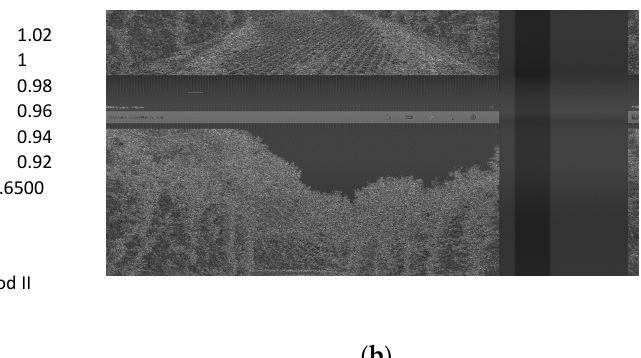
and ( b ) image reconstructed on the basis of the recorded revealing emission signal at frequency f o = 1334 MHz (receiving bandwidth BW = 50 MHz) for estimated line length d ∆ = 1953.64900 (accuracy ∆ = 0.001)—multiple of image summation Sum MTL = 30, the source of revealing signal emission—display monitor, HDMI standard.